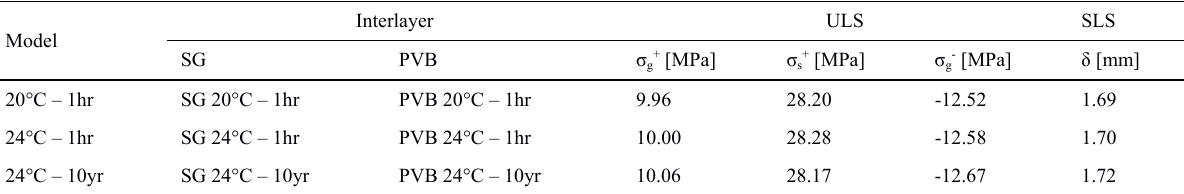
Table 5: Maximum values of stresses and vertical displacement.